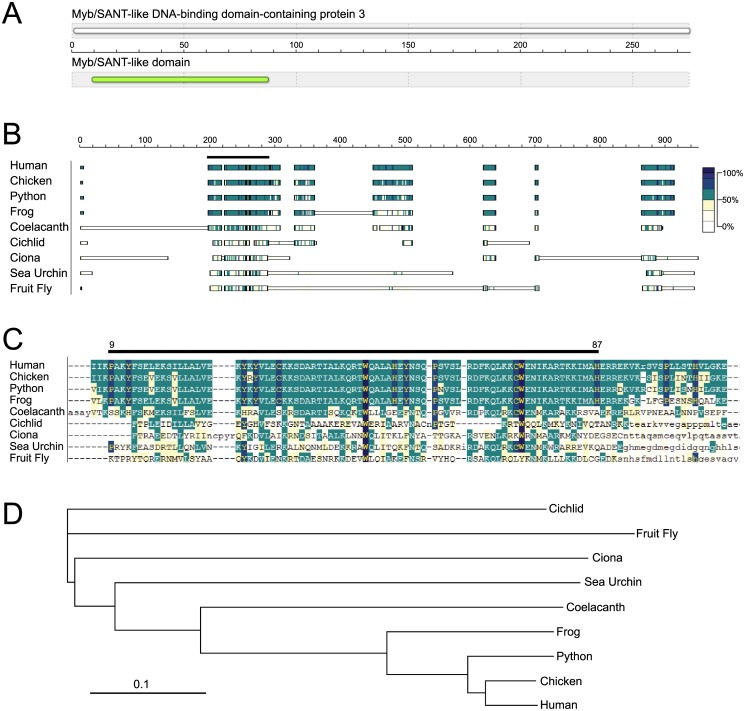
MSANTD3 structural domains and phylogenetic conservation.(A) Schematic depiction of MSANTD3 domains, showing the location of the Myb/SANT-like domain within the N-terminus. (B) Schematic depiction of MSANTD3 MACAW sequence alignments across species. Boxes indicate conserved blocks, while the shading indicates pair-wise scores relative to human MSANTD3 with colors indicated in the key. Above, the horizontal black bar indicates the location of the conserved Myb/MSANT domain found by NCBI search (Pfam 13873). (C) Actual MACAW alignment within the MYB/SANT region. (D) Phylogenetic tree based on the global alignment made by ClustalX and visualized using Treeview software.